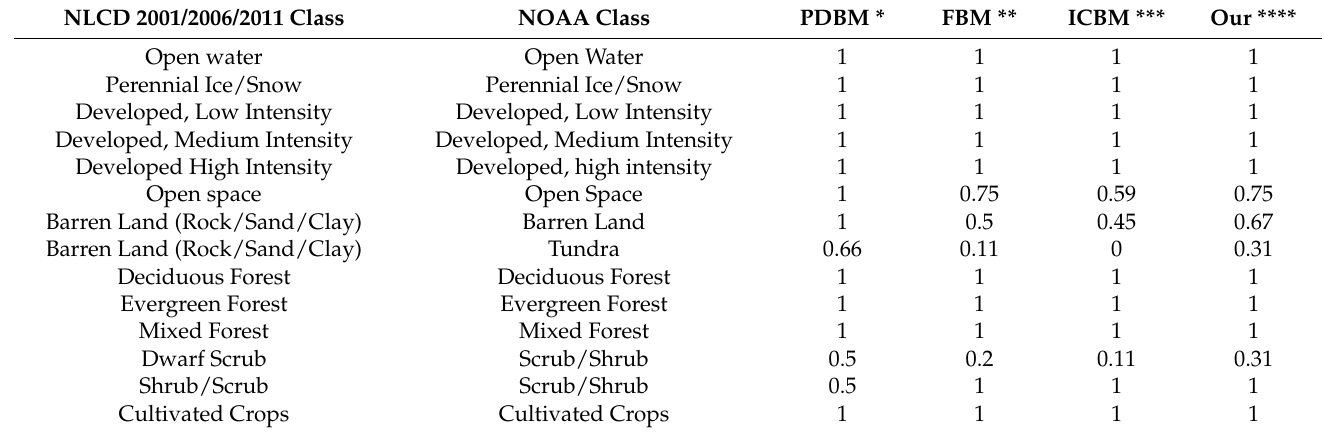
Table 6. Results of semantic similarity measuring between and NLCD 2011/2006/2011 and NOAA Regional Land Cover Classification